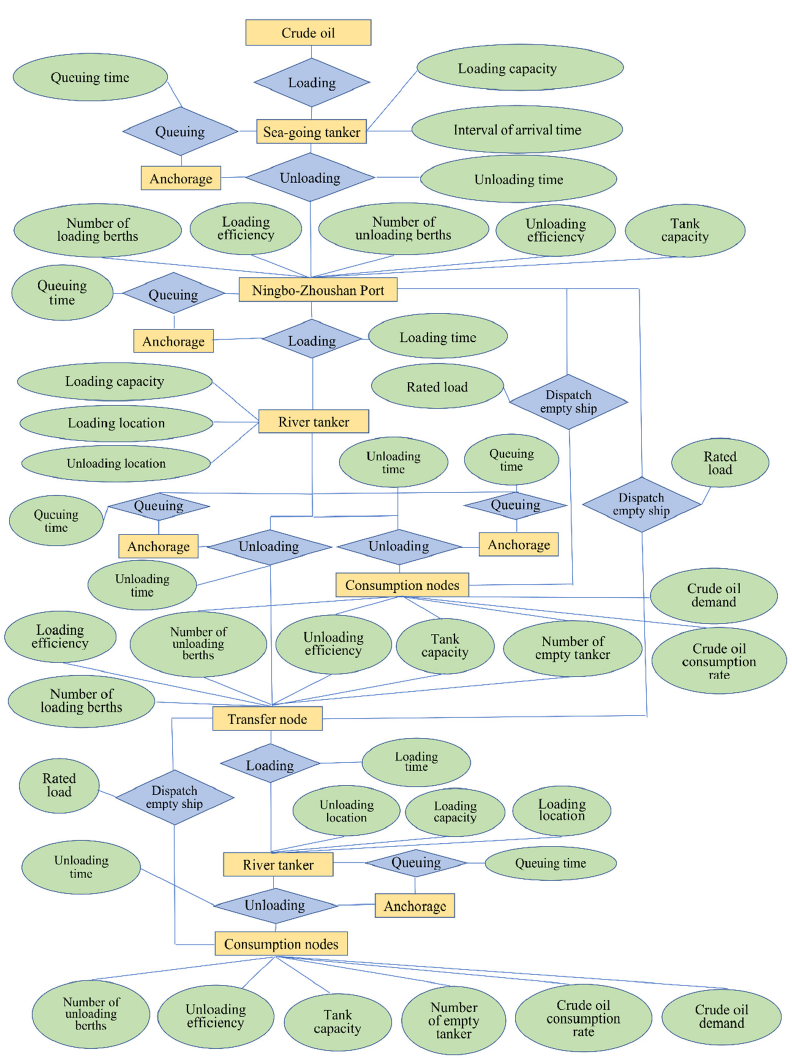
Figure 4. The ERD conceptual model of the Yangtze River’s crude oil sea–river transfer system.